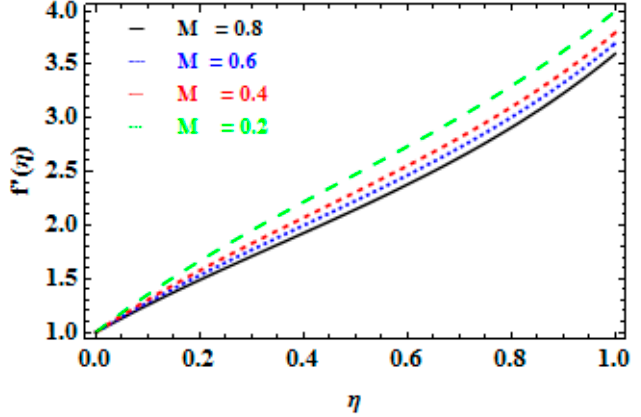
Figure 10. Influence of M on 𝑓 (cid:4593) ( 𝜂 ) .